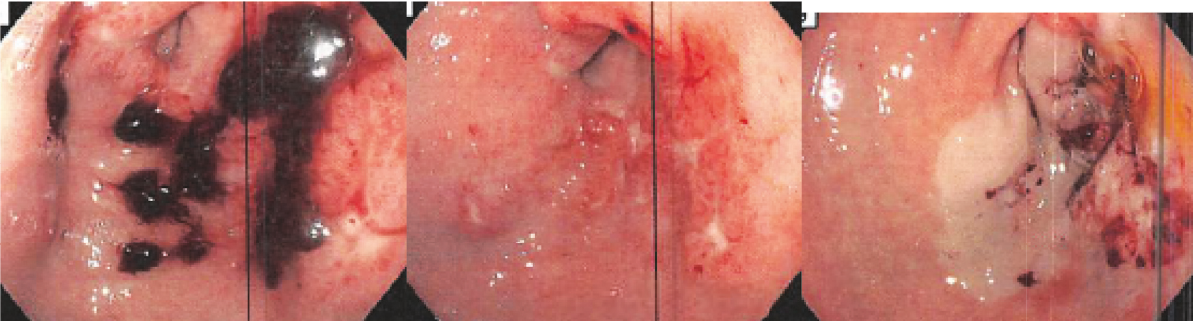
Figure 3: BICAP multipolar heater probe and epinephrine application following additional